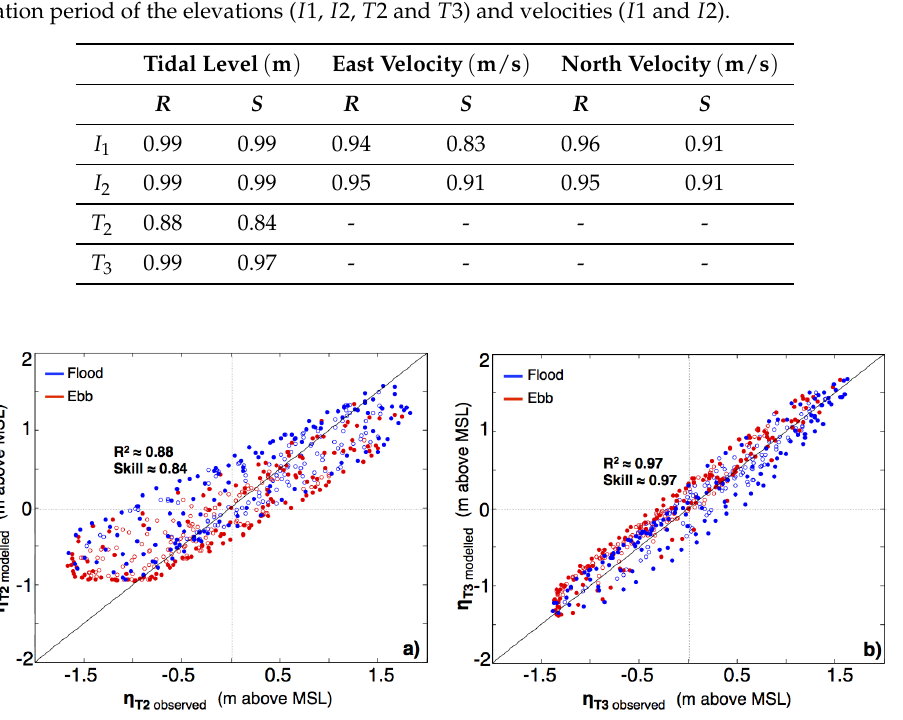
Table 3. Root mean square errors ( RMSE ), correlation coefficients ( R ) and skill coefficients ( S ), for the